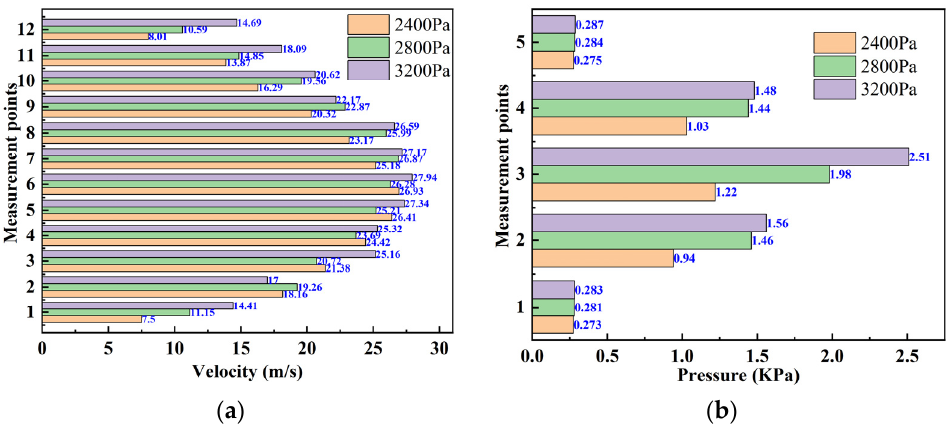
Figure 14. Flow field characteristics of the dust suction port at different negative pressures: ( a ) average velocity at the vacuum inlet; ( b ) average pressure at the dust suction port outlet.